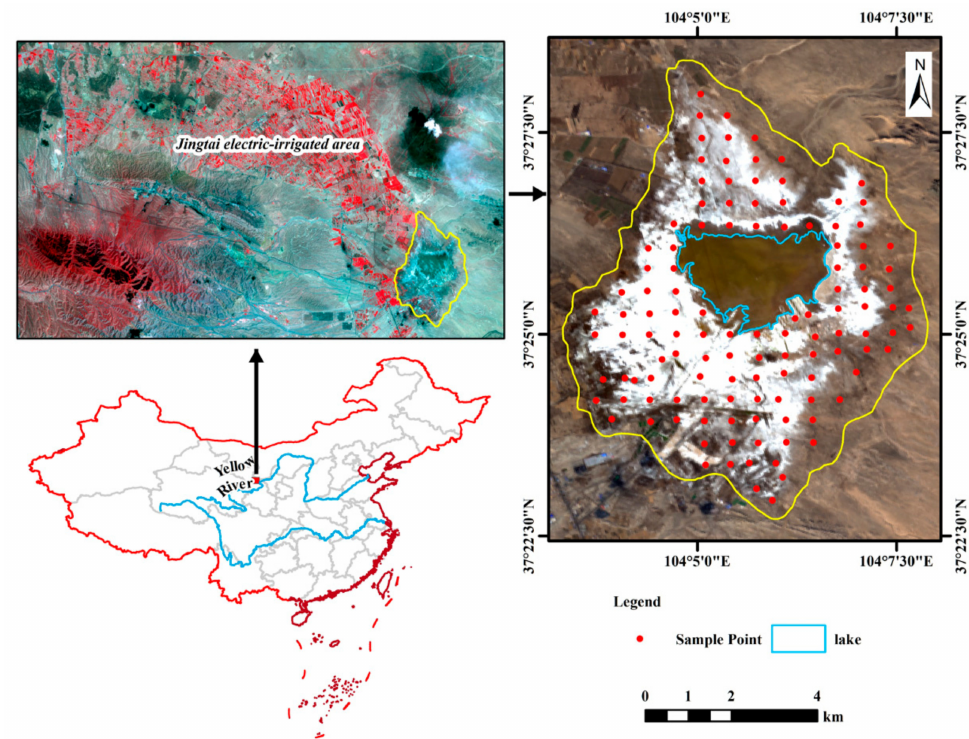
Figure 1. Location of the study area in China and in the Jingdian Irrigation Area, and the locations of collected